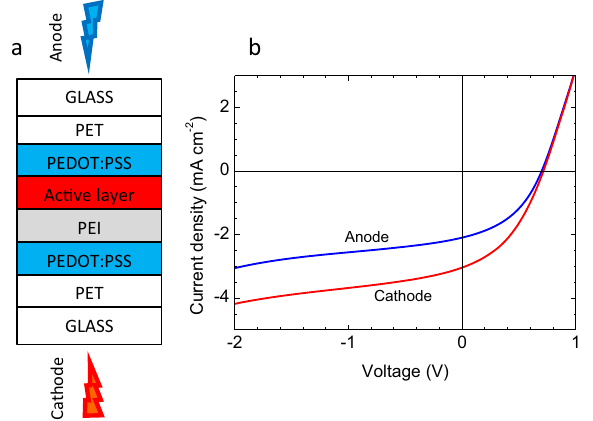
Fig. 2 Assymetric photo current a Schematic of the laminated solar cell stack illuminated either through the anode (blue) or the cathode (red) side. b JV curves for an ambient-processed solar cell illuminated through the anode (blue) and through the cathode (red)